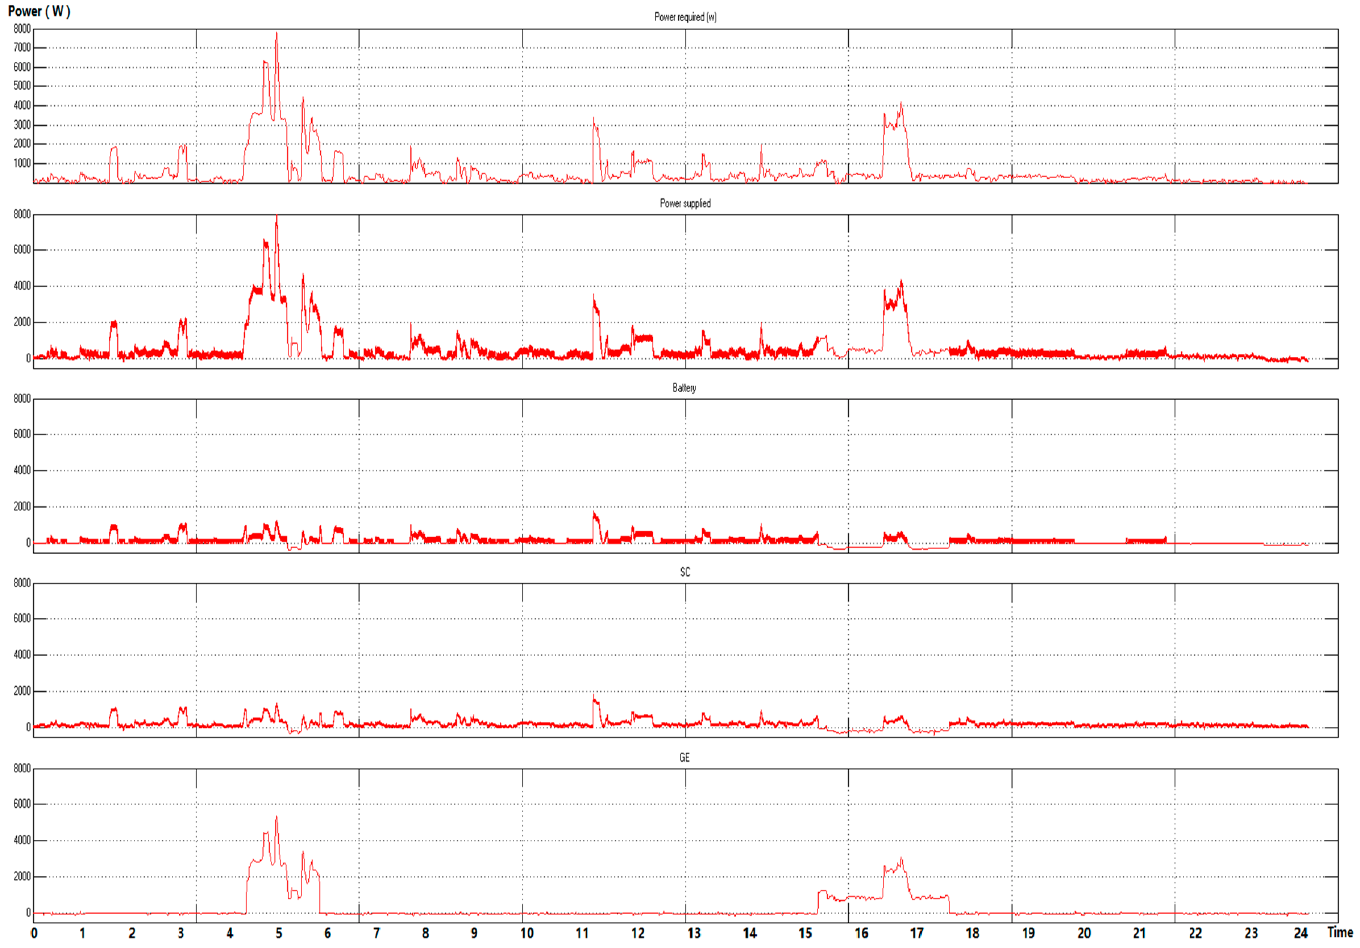
Figure 7. Winter day simulation results.